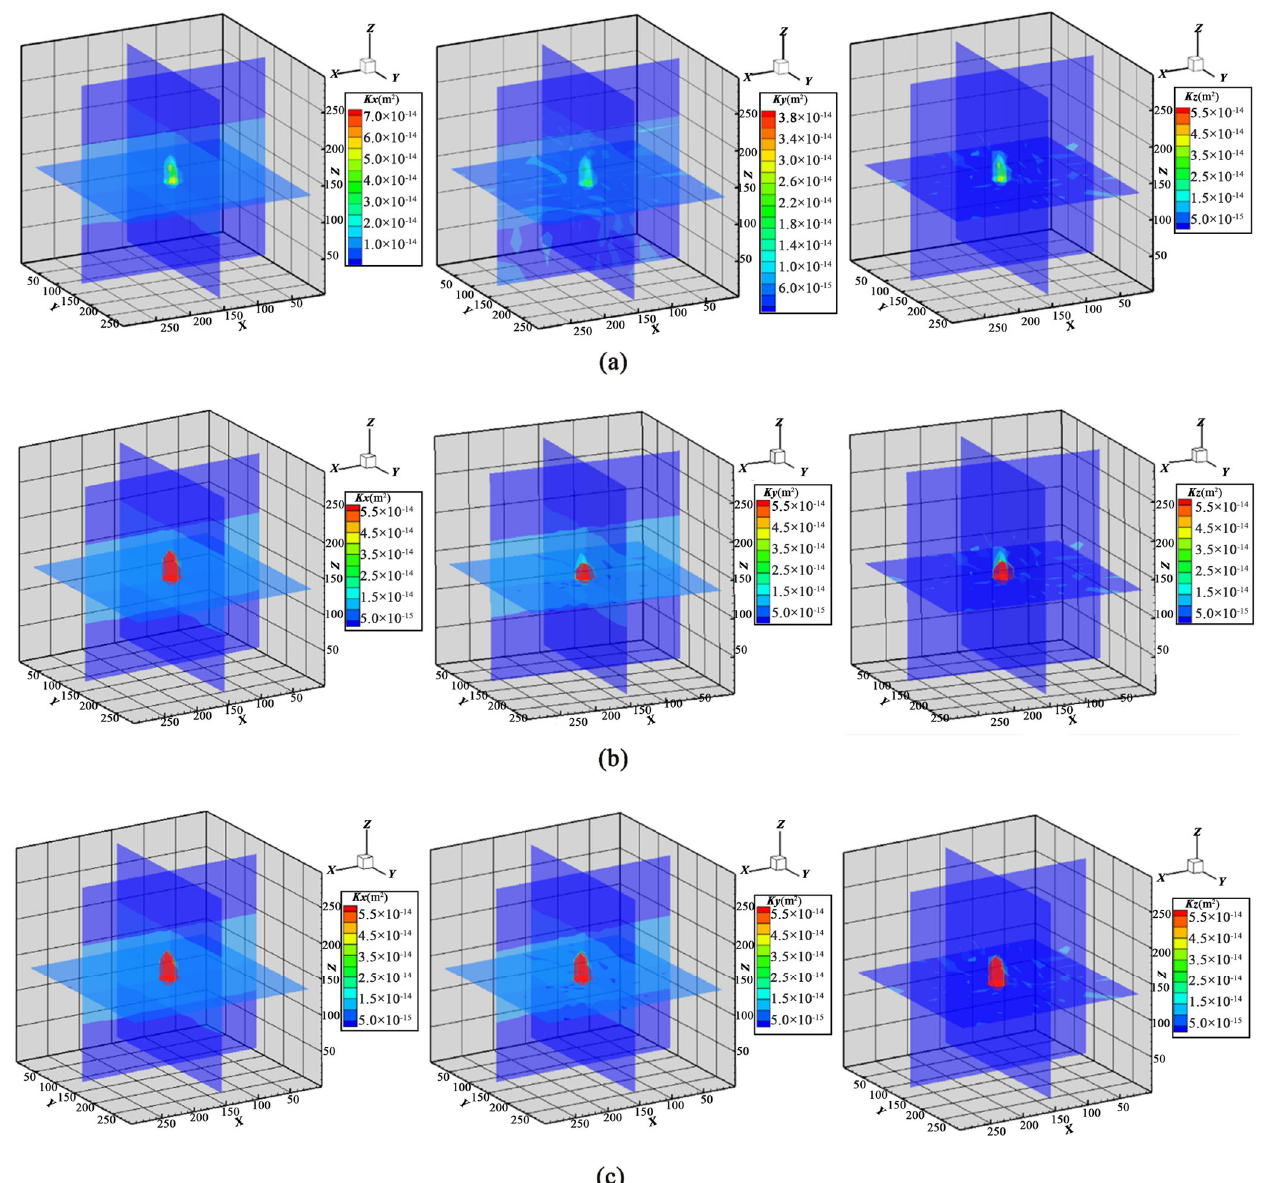
Figure 10. Permeability of reservoir in x , y , z directions after: ( a ) first stage; ( b ) second stage; ( c ) third stage.